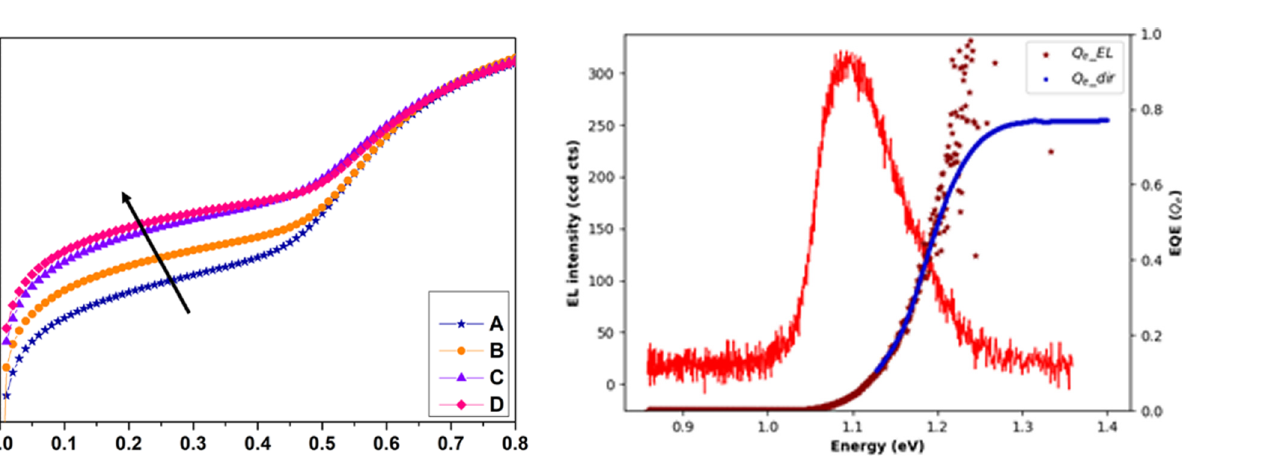
Fig. 10. EL spectrum (red line) and measured external quantum ef fi ciency Q e _ dir (solid circle). Note that EL spectrum Fig. 9. Semilogarithmic plots of dark IV curves of bottom cells corresponds to the ’ em ( E ) in equation (3). Star points represent A, B, C, and D for 3T devices. The black arrow indicates the the calculated quantum ef fi ciencies Q e _ EL that follow from EL direction of decrease of the shunt resistance. The samples C and D spectrum using equation (3). have then less shunt resistance (152 V cm 2 and 118 V cm 2 ) than the samples A and B (827.6 V cm 2 and 372.5 V cm 2 respectively). Shunt Resistance value is obtained by a two-diode fi t model). Table 1. Si-IBC (2) external photovoltaic parameters calculated as speci fi ed in the theory section, compared with 2T Silicon device parameters from Kirchartz et al. [23]. SQ-values under AM1.5G illumination saturation current , short circuit current density J and open density J sc , SQ 0, SQ are compared the spectral responsed circuit voltage V oc , SQ , V and to the EL and EQE analysis parameters values J sc oc J , V oc , rad 0, rad